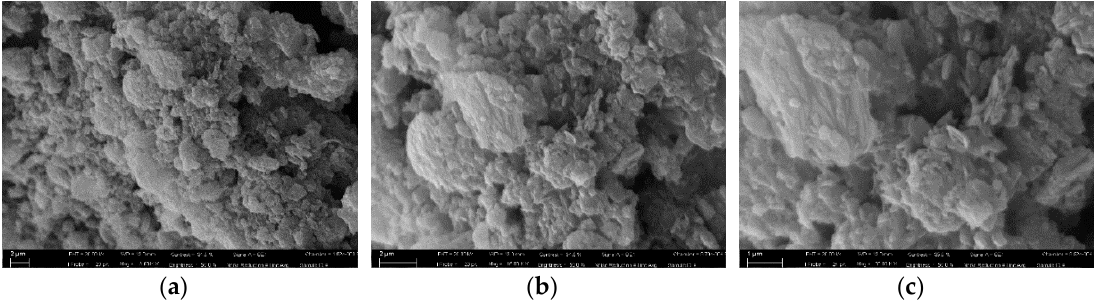
Figure 1. SEM images of the Zeolite-salycilate powder taken at different magnifications. ( a ) 8000X; ( b ) 16,000X; ( c ) 30,000X.